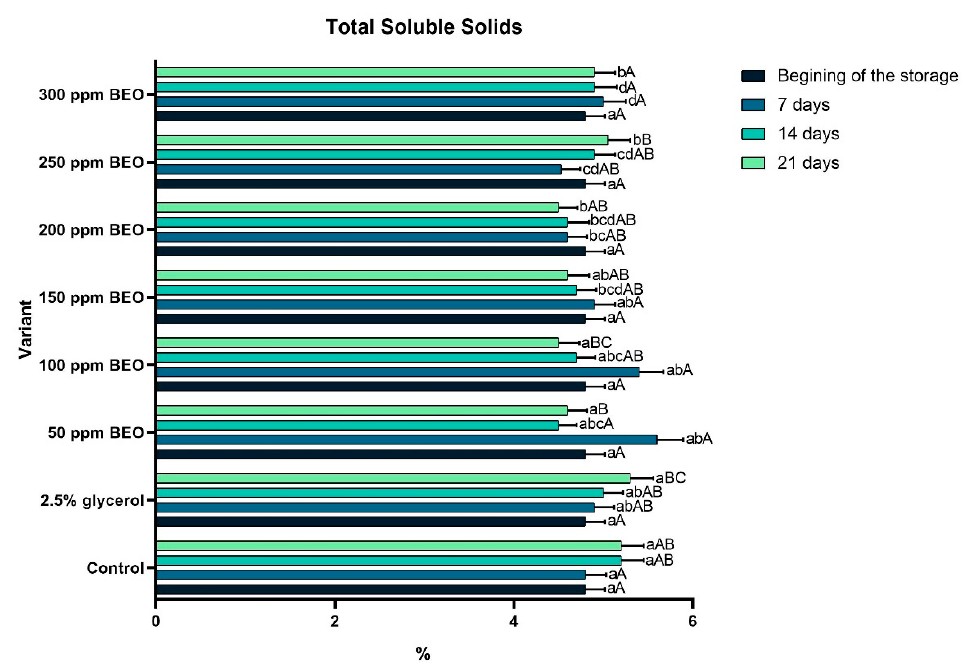
Figure 4. Effects of applied treatments on total soluble solids (%) during storage for 21 days at 8 ± 1 °C. Bars for the same sampling time followed by different lowercase letters are significantly different based on the least significant difference (LSD) test ( p < 0.05). Bars for the same treatment during storage time followed by different uppercase letters are significantly different based on the least significant difference (LSD) test ( p < 0.05).